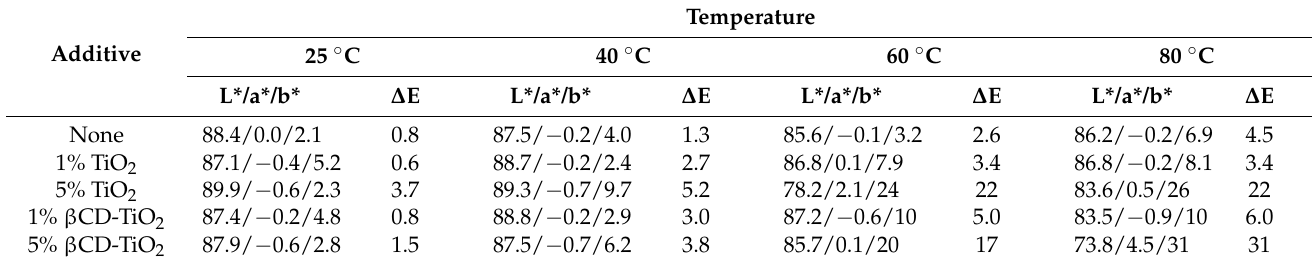
Table 2. L*, a*, b*, and ∆ E color parameters obtained for polyvinyl alcohol (PVA) composite films after aging at different temperatures and 80% relative